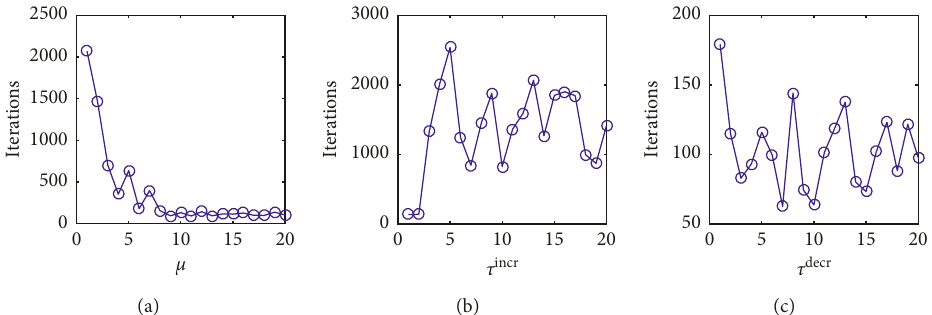
Figure 2: Effect of μ (a), τ incr , (b) and τ decr (c) in terms of average number of iterations taken to converge. For each setting, a-ADMM is performed 50 times on the UAV control task ( N � 10) with random initial states.